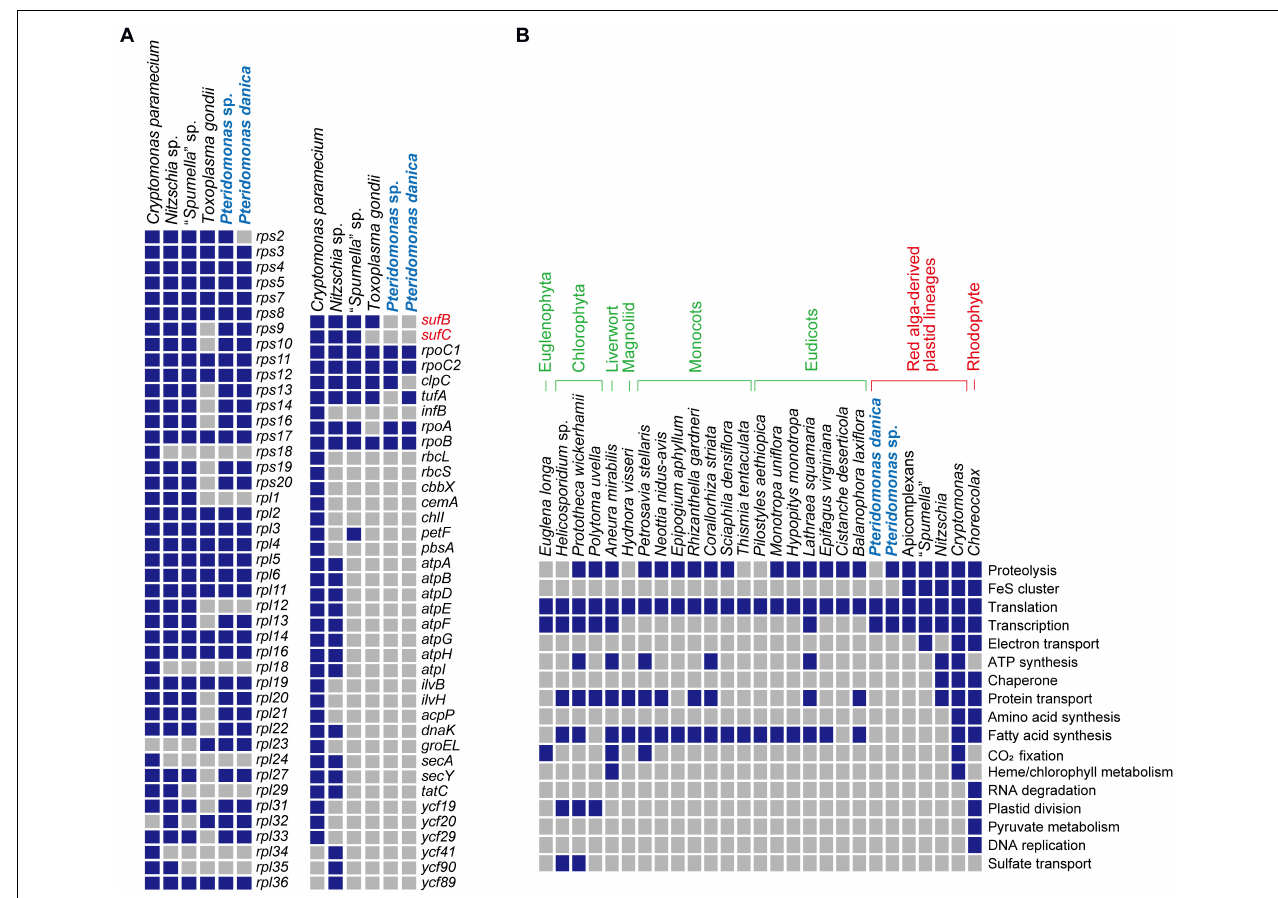
FIGURE 3 | Comparison of non-photosynthetic plastid genomes. (A) Comparison of plastid gene contents from non-photosynthetic organisms with red alga-derived plastid. Nitzschia sp. NIES-3581 (Bacillariophyceae; GenBank no. AP018508; Kamikawa et al., 2015), Cryptomonas paramecium (Cryptophyta; GenBank no. GQ358203; Donaher et al., 2009), Toxoplasma gondii (Apicomplexa; GenBank no. U87145; Köhler et al., 1997), “ Spumella ” sp. NIES-1846 (Chrysophyceae; GenBank no. AP019363; Dorrell et al., 2019) were used for comparison. Presence and absence are shown by blue and gray boxes, respectively. (B) Comparison of the estimated functions encoded in non-photosynthetic plastid genomes. All the data except for Pteridomonas spp. highlighted in light blue are derived from Hadariová et al. (2018) and Dorrell et al. (2019).